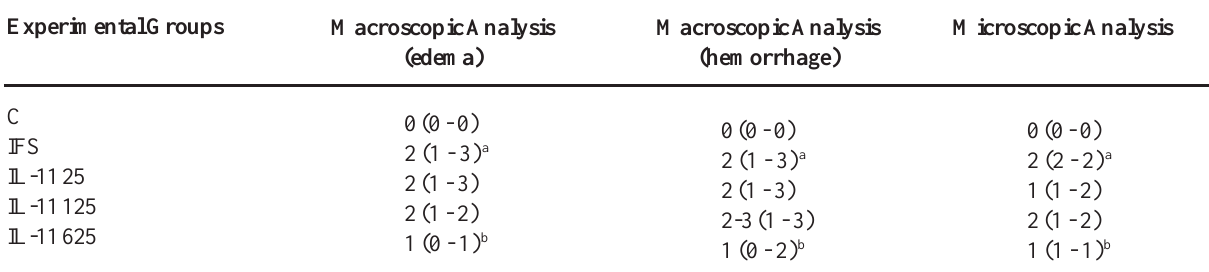
Table 1 – Macroscopic and microscopic analysis of rhIL-11 effect on ifosfamide-induced hemorrhagic cystitis. Experimental Groups